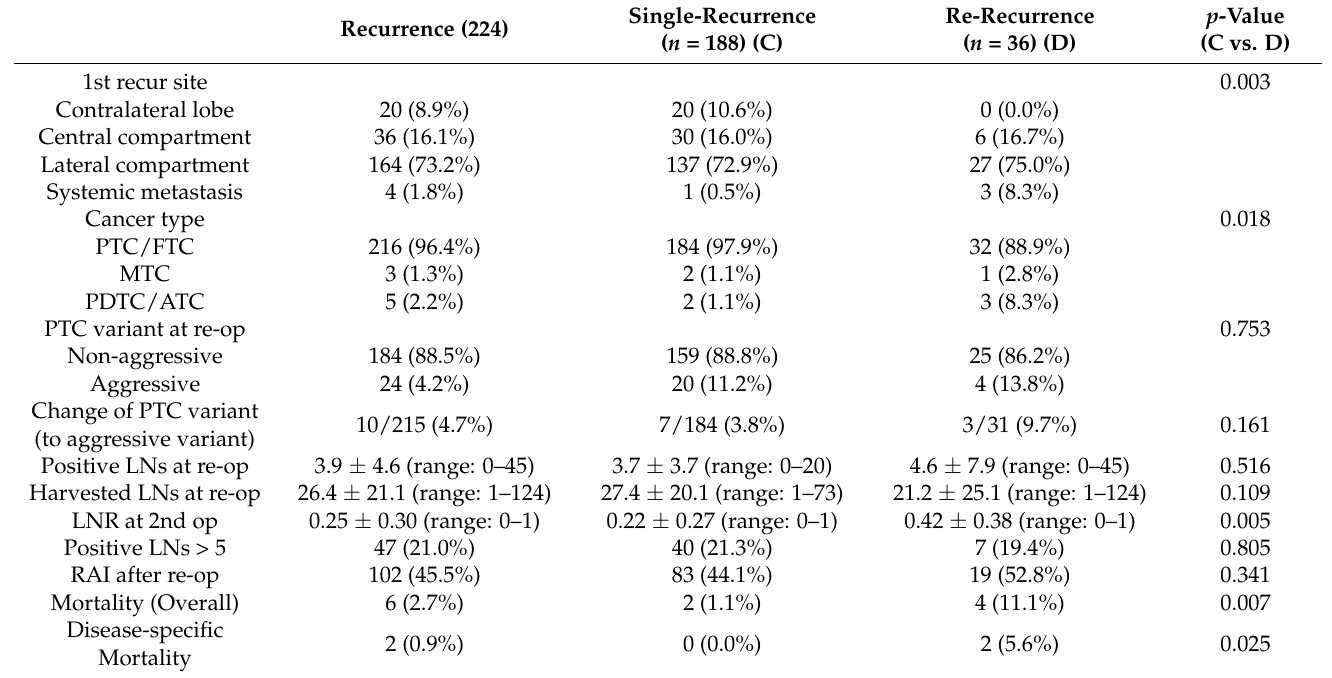
Table 4. Surgical outcomes in patients who underwent reoperation at the 1st recurrence. Recurrence (224)